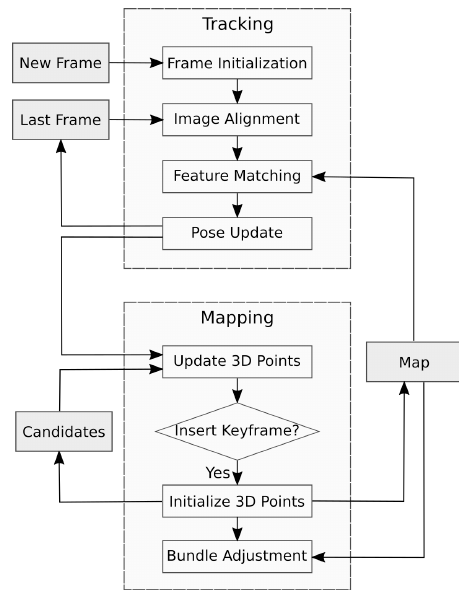
Figure 1. Tracking and mapping